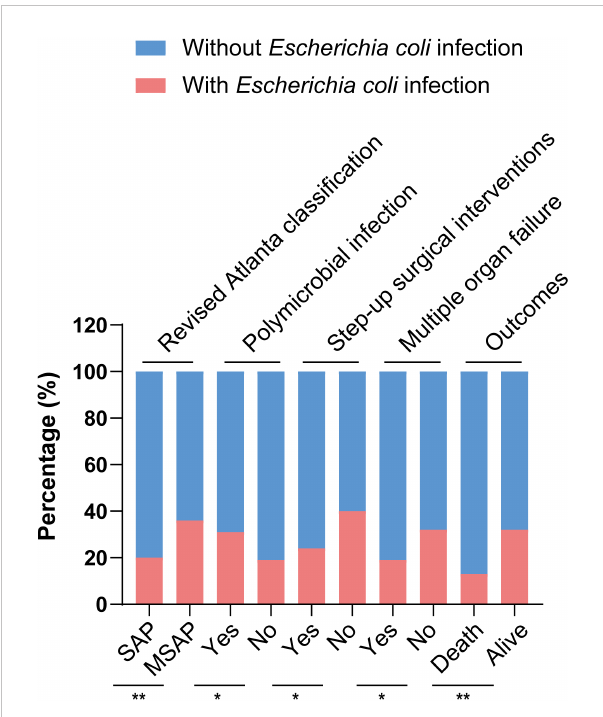
FIGURE 2 Comparisons of clinical characteristics between patients with and without Escherichia coli infection,. *p < 0.05 and ** p <